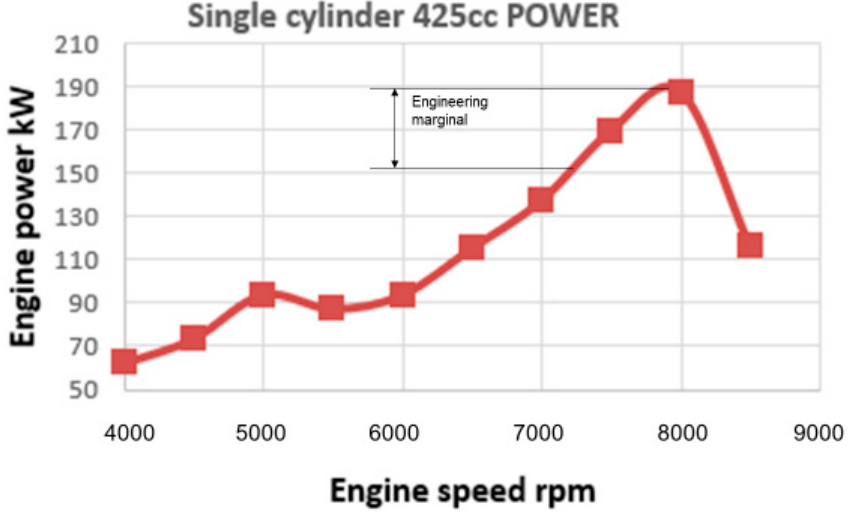
Figure 5. The upscaled 425 cc engine comfortably exceeded the desired power output of 150 kW, giving a large engineering margin.